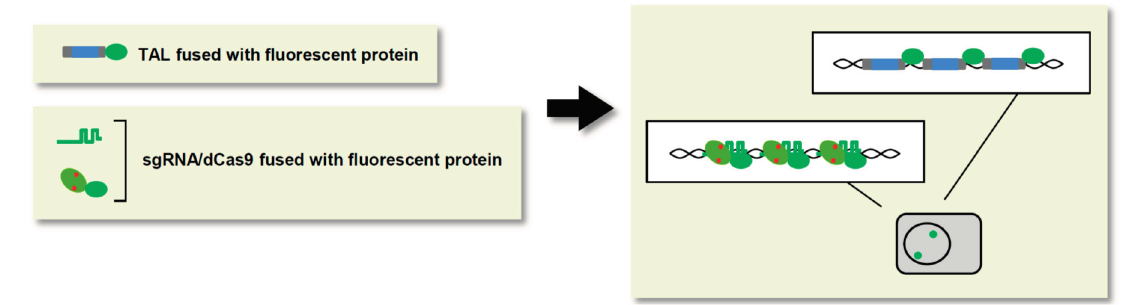
Figure 3. Locus visualization for live imaging. Fusion of fluorescent proteins to TAL or dCas9 enables visualization of target loci in living cells. Fluorescent protein: green ellipse; visualized loci: green